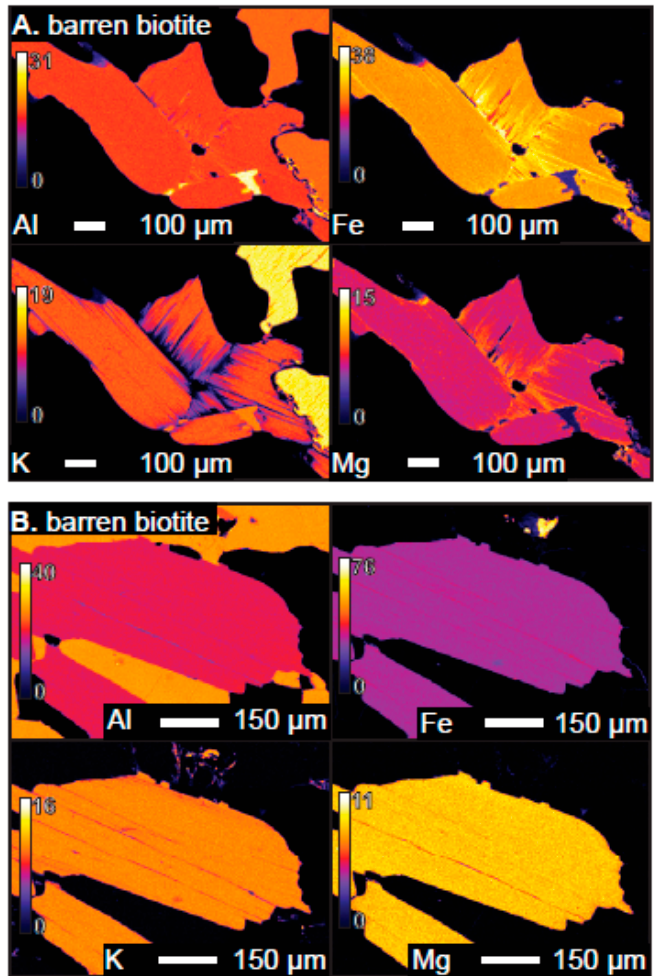
Figure 6. WDS elemental chemical maps of the four biotite types with increasing metamorphic grade: ( A ) and ( B ) biotite from barren host rocks metamorphosed to subgreenschist and greenschist facies, respectively (DLR-03, DLR-02). Warm colours are higher elemental concentrations; cool colours are lower elemental concentrations. Note, colour-scales show wt% oxide concentrations and are individually adjusted for each map to best visualize chemical heterogeneities. Chemical maps from all barren biotite types reveal homogeneous compositions with slightly Fe-rich and K-poor cleavage planes.